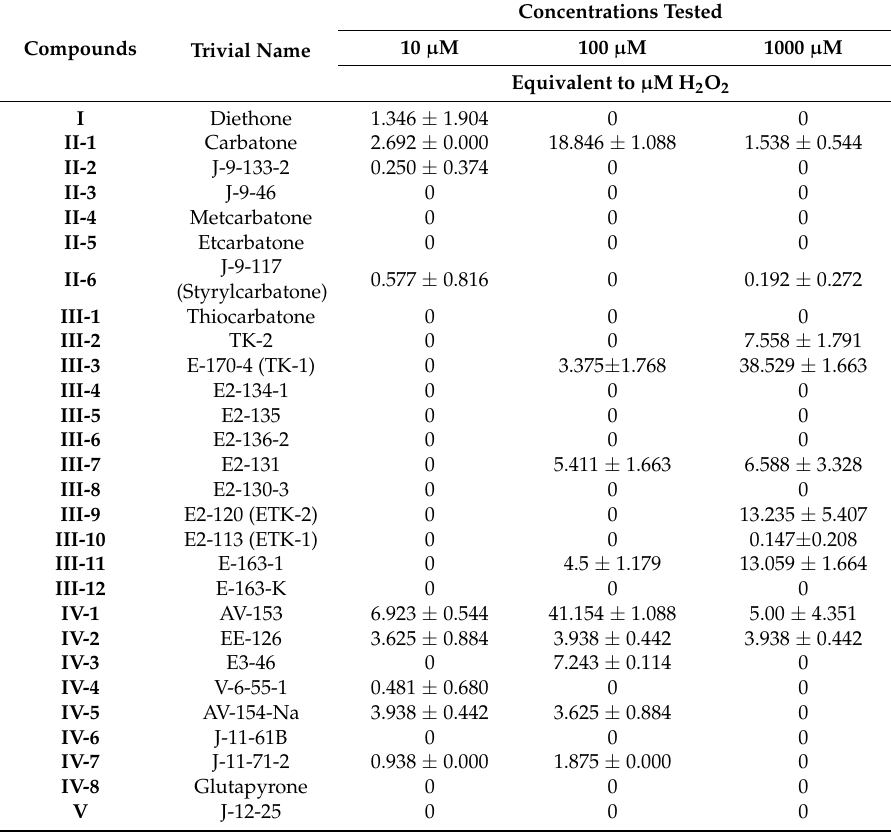
Table 3. The oxidative capacity of selected compounds expressed as equivalent to µ M H 2 O 2